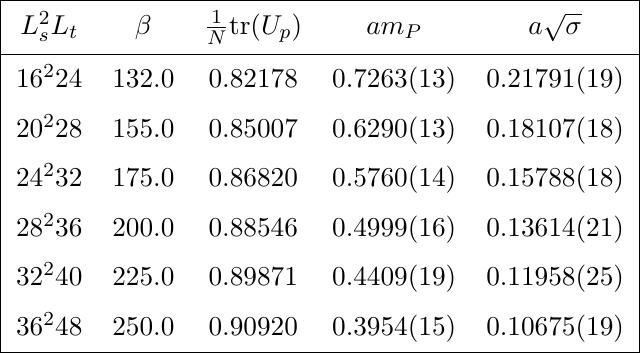
Table 17 . SO(12) average plaquette values, (cid:13)ux loop masses, and string tensions.